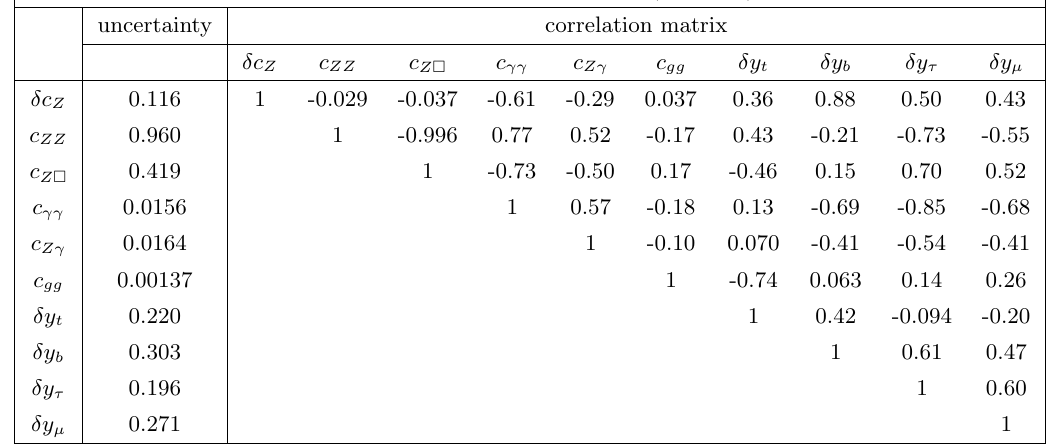
Table 9 . One sigma constraints and the correlation matrix of the Higgs basis parameters from the LHC 14 TeV Higgs measurements with 300 fb (cid:0) 1 data, using the ATLAS projection with no theory error [73]. (cid:14)y c to set to zero since ref. [73] did not provide estimations for the decay h